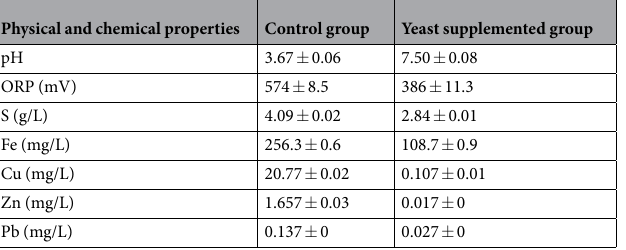
Table 1. Physical and chemical properties of exudate between control group and yeast extract sprayed